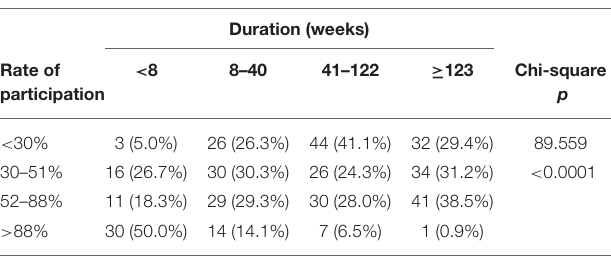
TABLE 2 | Relationship between duration of and intensity of participation in 375 families with more than one week of